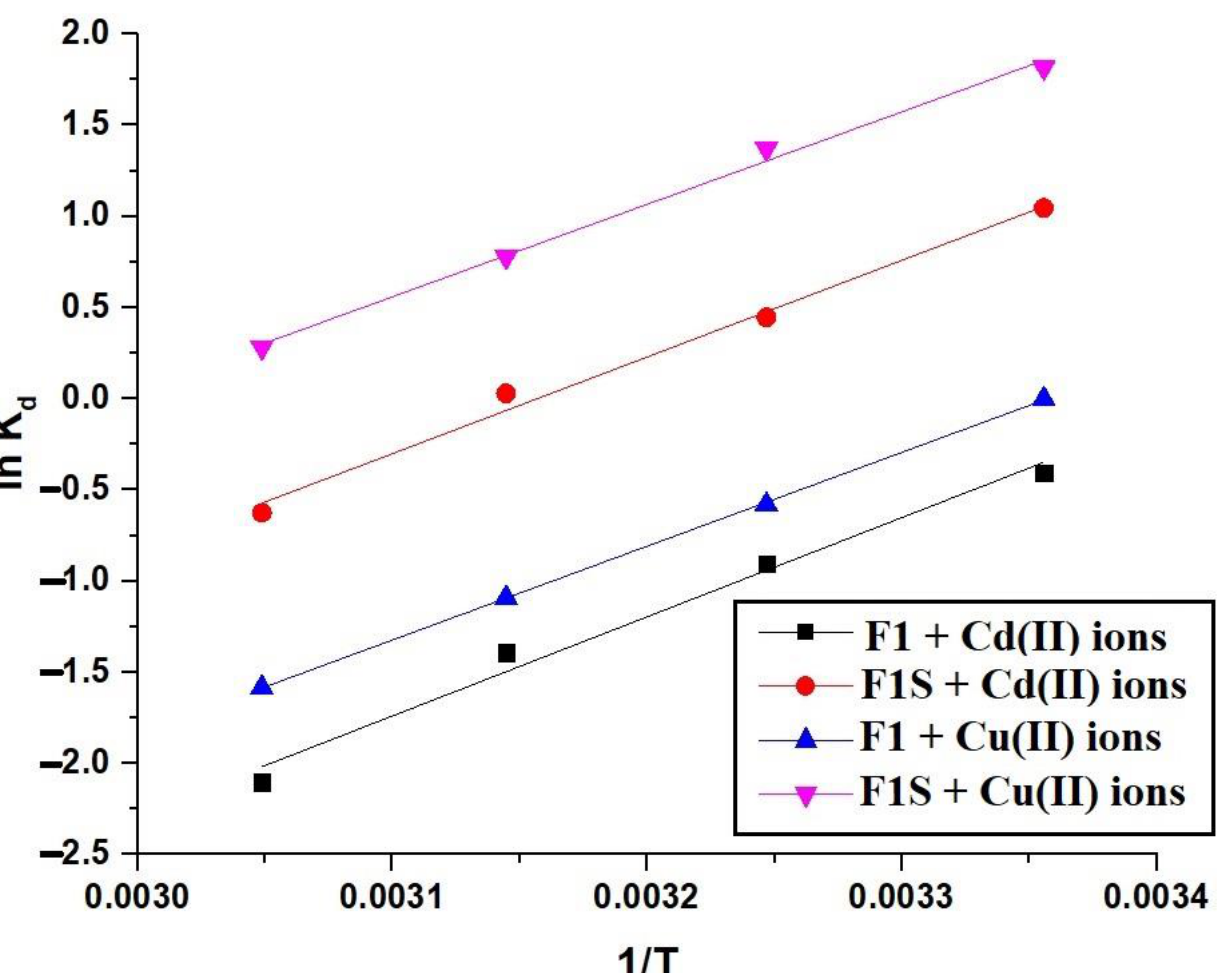
Figure 10. The plots of lnK d versus 1/ T for the removal of cadmium and copper ions using the F1 and F1S samples. Table 4. The thermodynamic constants for the removal of cadmium and copper ions using the F1 and F1S samples.